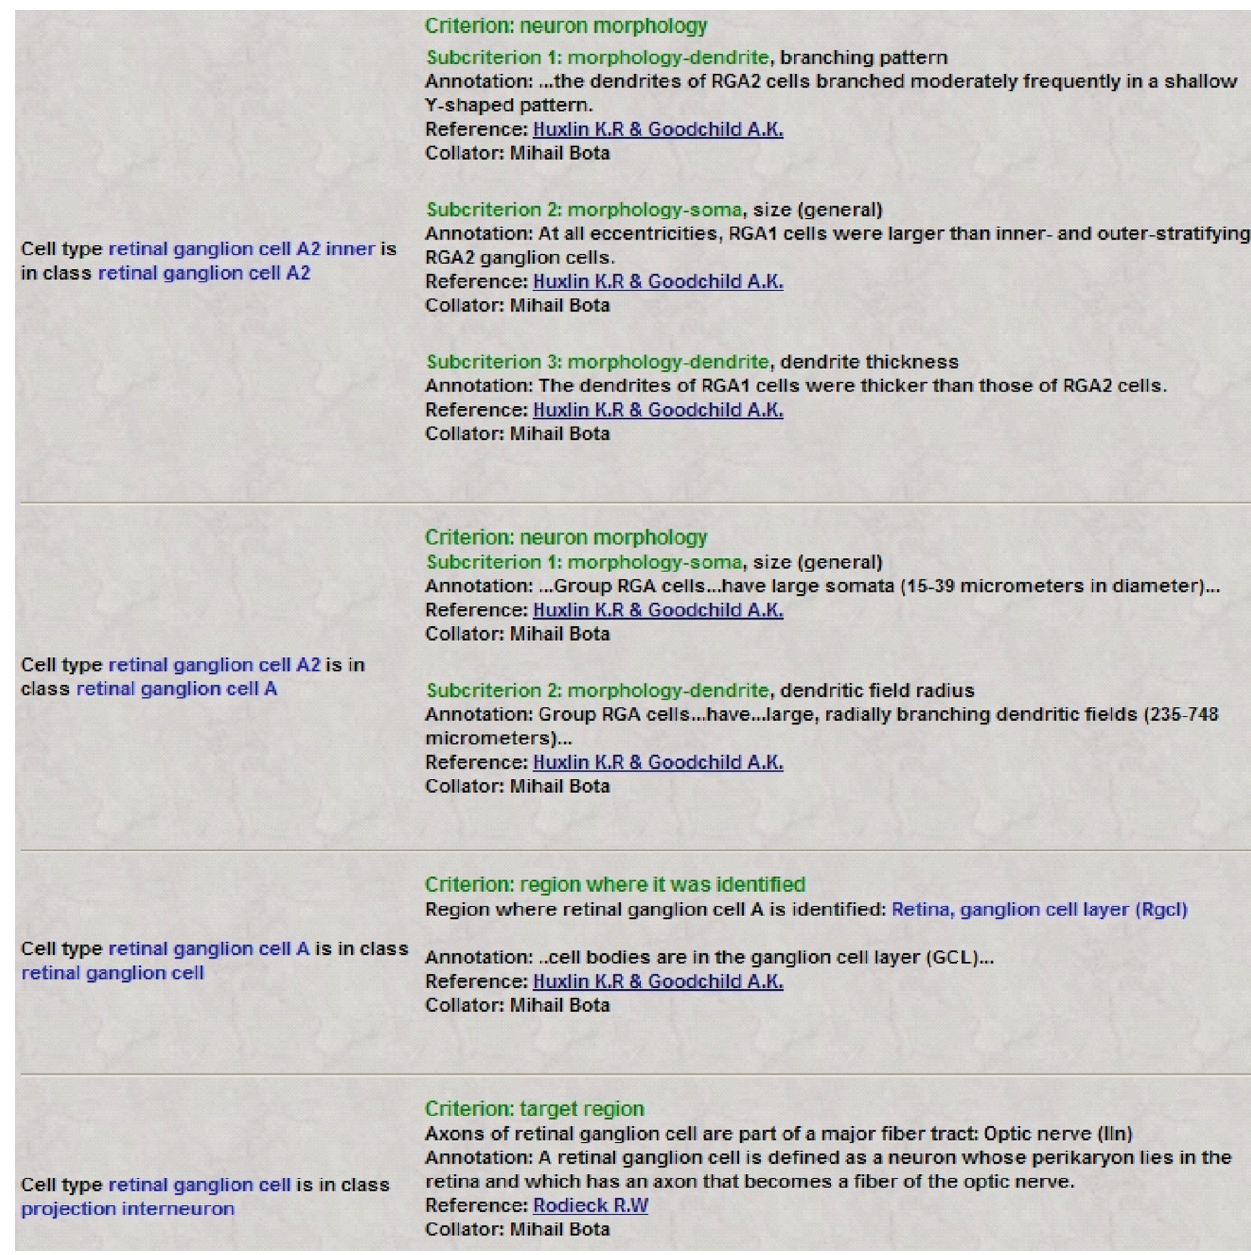
Figure 7. Users can access classifi cation criteria associated with each “is a” relationship included in BAMS Neuroanatomical Ontology . Retrieved cri- teria are organized as ordered lists of variables used to defi ne and classify the neuron concepts. Associated information includes textual annotations, references, and collator names. The list of variables shown in this Figure is used to classify rat retinal ganglion cells A2 inner (Huxlin and Goodchild, 1997) as projection interneurons, passing through the intermediary